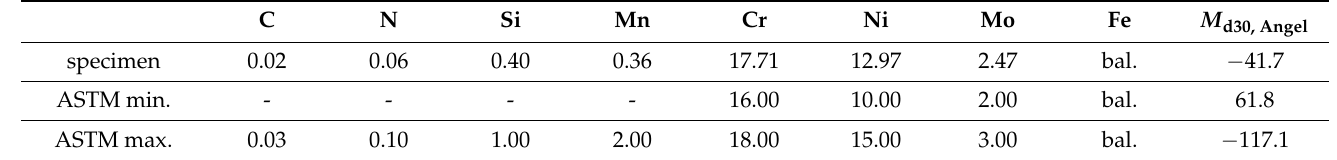
Table 1. Chemical composition in wt.% and resulting M d30,Angel in °C of the specimen investigated as well as the limits defined in the ASTM standard [26].